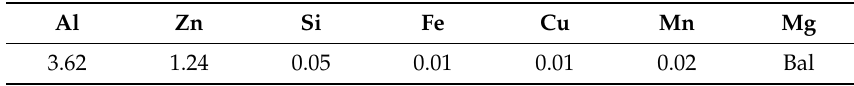
Table 1. Chemical compositions (in wt.%) of the base metals.